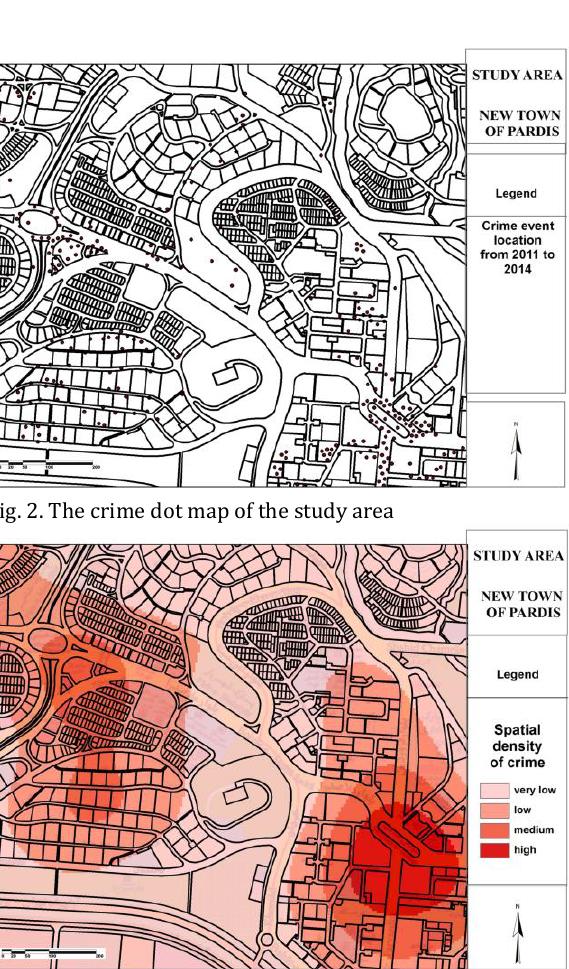
Fig. 3. Crime density map of Pardis new town